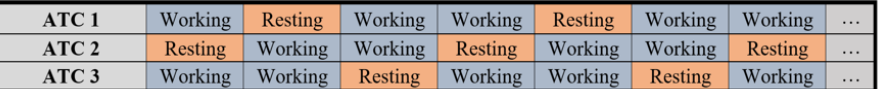
Figure 3. Template 1 × 3 (1 sector is controlled by 3 air traffic controllers (ATCs), two working, executive and planner, and one